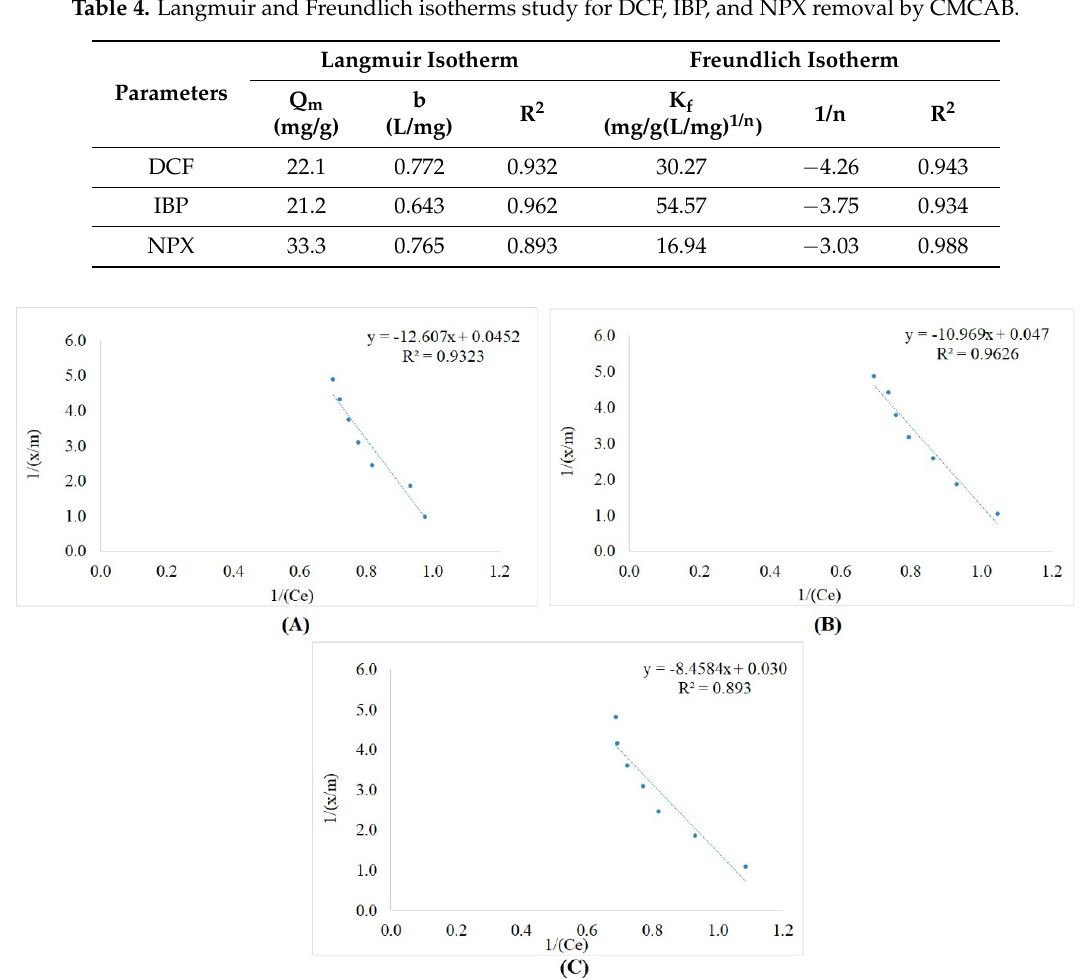
Figure 10. Langmuir isotherm regressions for diclofenac ( A ), ibuprofen ( B ), and naproxen ( C Table 4. Langmuir and Freundlich isotherms study for DCF, IBP, and NPX removal by CMCAB. Langmuir Isotherm Freundlich Isotherm Parameters